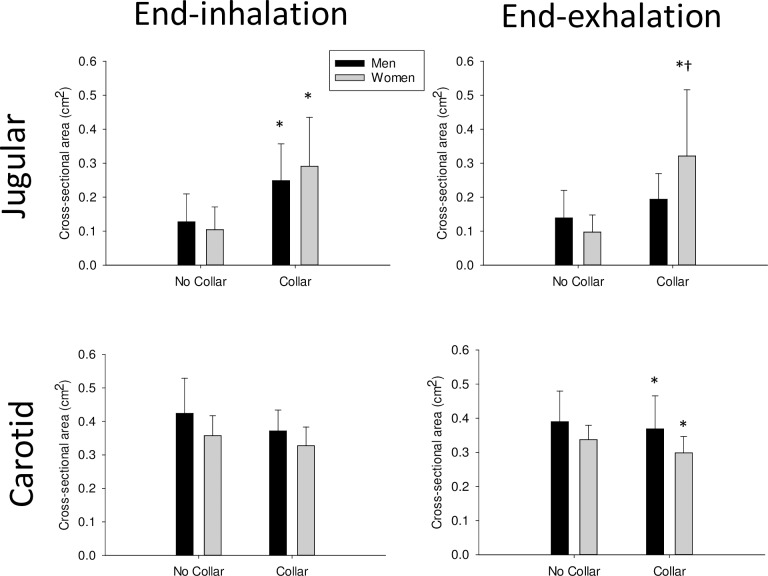
Jugular vein (top panels) and carotid artery (bottom panels) cross sectional area at the end of an inhalation (left panels) and at the end of an exhalation (right panels) in men and women with or without use of a compression collar. Men are black bars, women are grey bars. *indicates a significant effect of Collar; †indicates a significant effect of sex within group; values are mean ± 95% Confidence Interval.